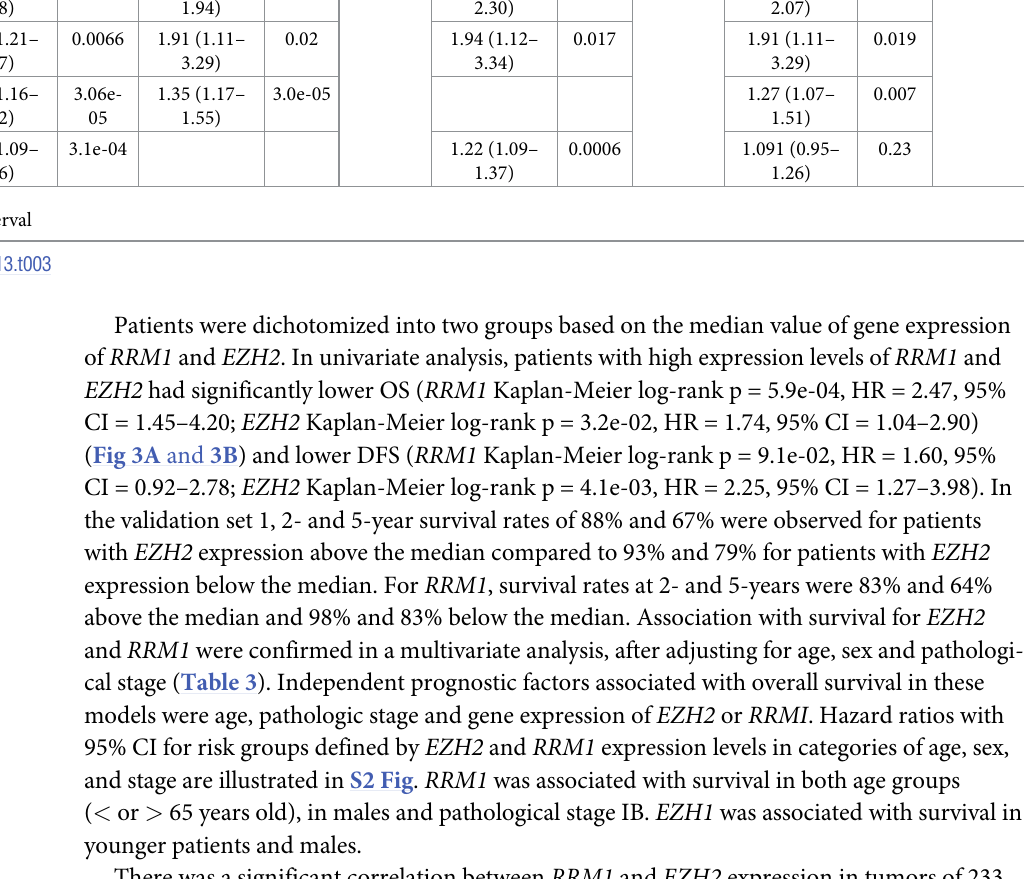
Table 3. Univariate and multivariate Cox regression analyses of prognostic genes for overall survival in validation set